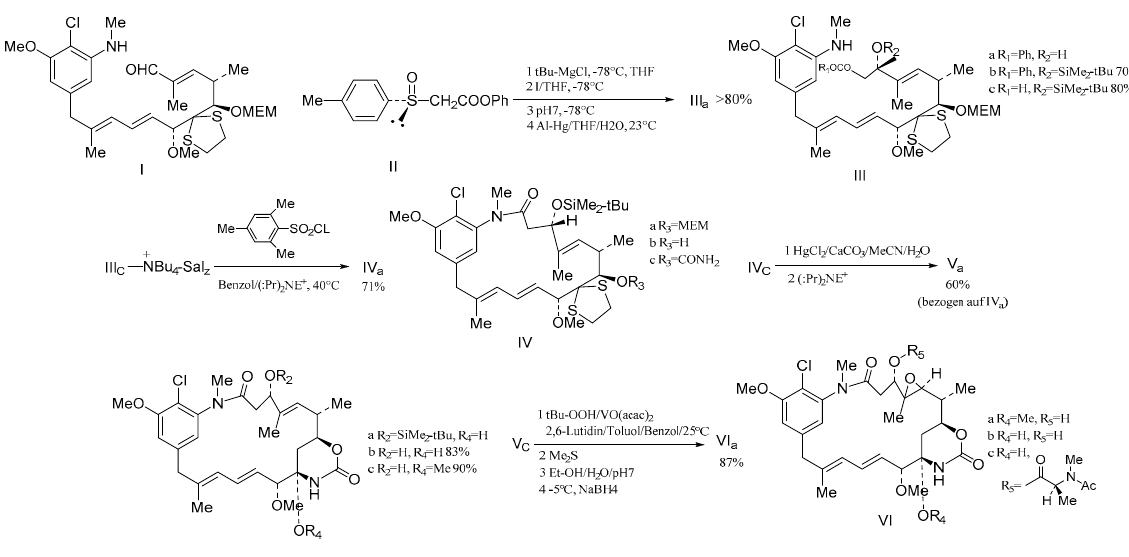
Figure 16. The stereo-selective synthesis of maytansine.